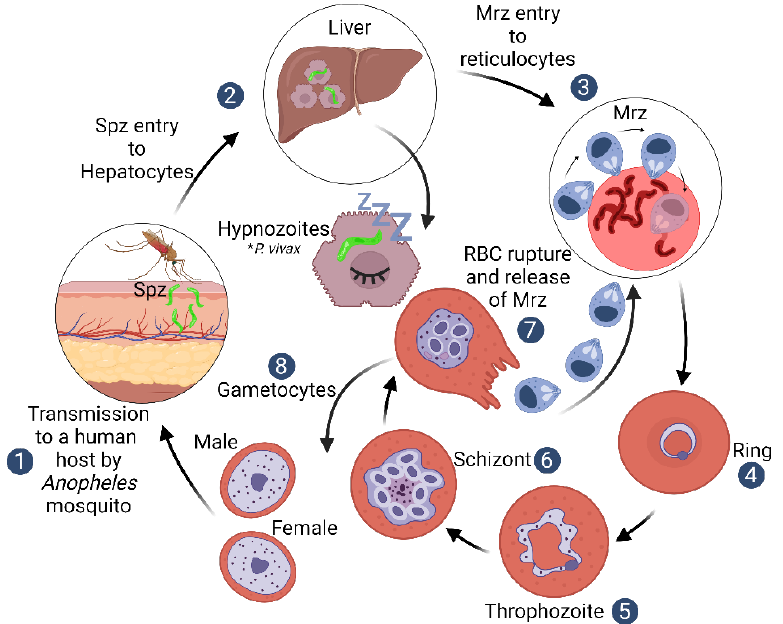
Figure 1. Plasmodium vivax life cycle. The life cycle of human malaria begins when a female Anopheles mosquito inoculates sporozoites (Spz) into a host’s dermis through its proboscis; these Spz invade hepatocytes in the liver and some of them remain as dormant liver-stage parasites – hypnozoites [10]. Each Spz forms thousands of Mrz that are released into the bloodstream and invade RBCs through specific receptor – ligand protein interactions, initiating a sequence of molecular events that commit the parasite to cell invasion [4]. The parasites undergo mitotic division and cytoplasmic growth during the next ~48 h inside the RBC to develop either directly into schizont (asexual) or gametocyte forms (sexual) [11] .